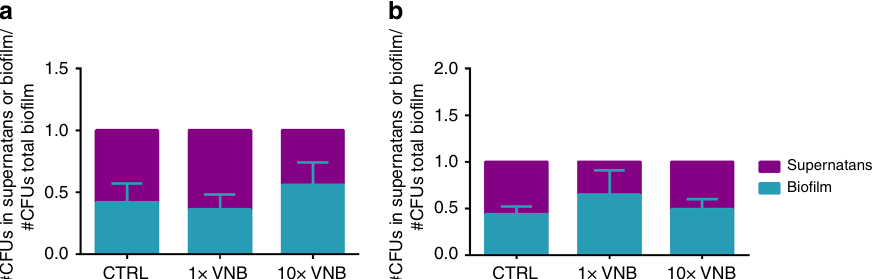
Fig. 8 Bacterial dispersal during VNB-treatment. The number of cells in the supernatants of a P. aeruginosa and b S. aureus bio fi lms was measured after 1× and 10× VNB treatment by plate counting (average ± SEM). No signi fi cant differences were found between any of the tested conditions ( p > 0.05). Each condition was tested in 3 biological repeats and each biological repeat consisted of 3 technical repeats ( n = 3 × 3). Statistical analysis was performed